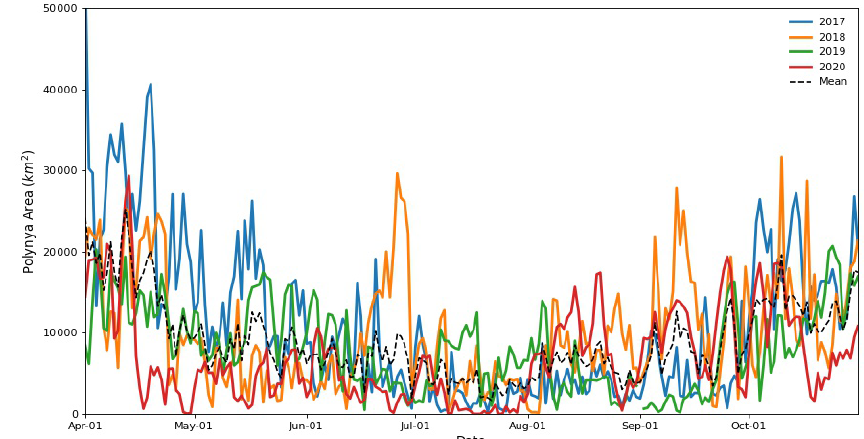
Figure 5. Daily winter (April–October) polynya area for each winter 2017–2020 (solid), and the 4-year mean of the daily areas for the whole winter period, as measured from AMSR-2 SIC data (dashed).